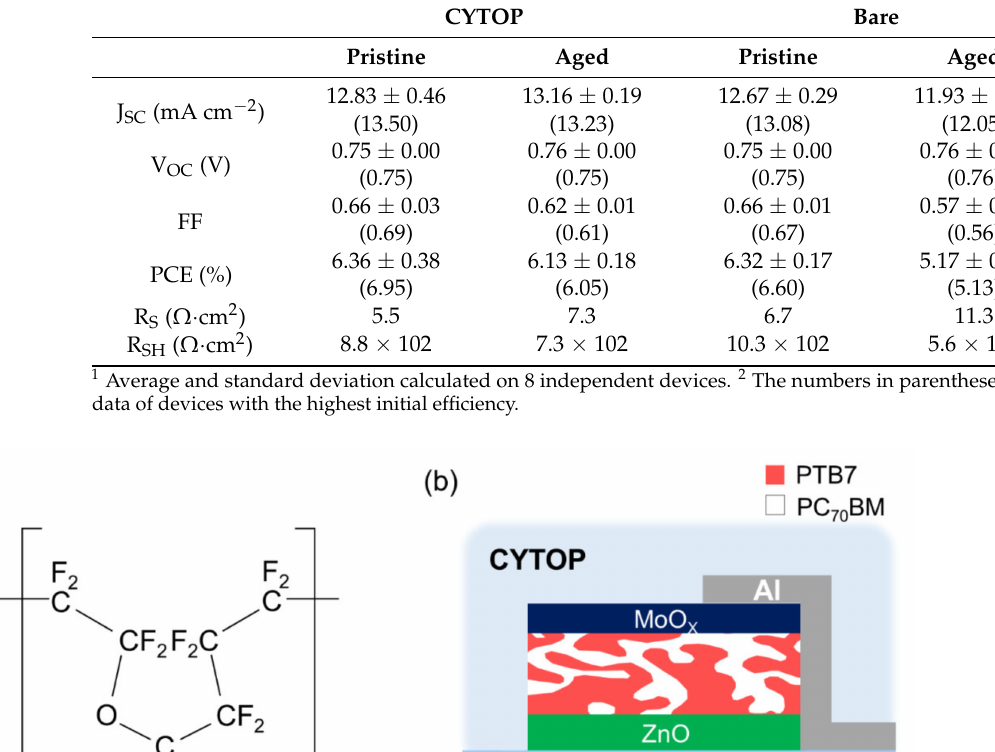
Table 1. Performance parameters 1,2 and resistive components of the CYTOP-encapsulated and bare devices before and after aging. CYTOP Bare Pristine Aged Pristine